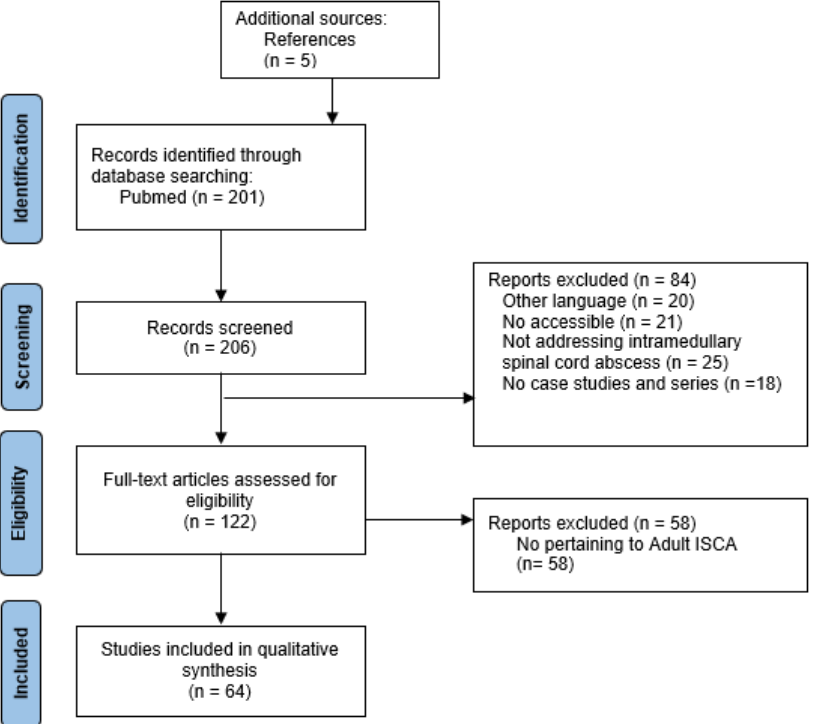
Figure 4. The flow-chart of publications included process.